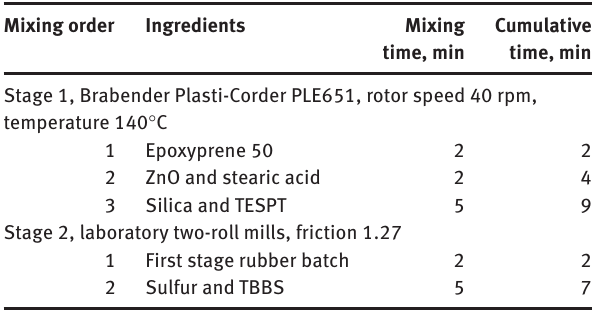
Table 2 Mixing schedule of the investigated rubber compounds.